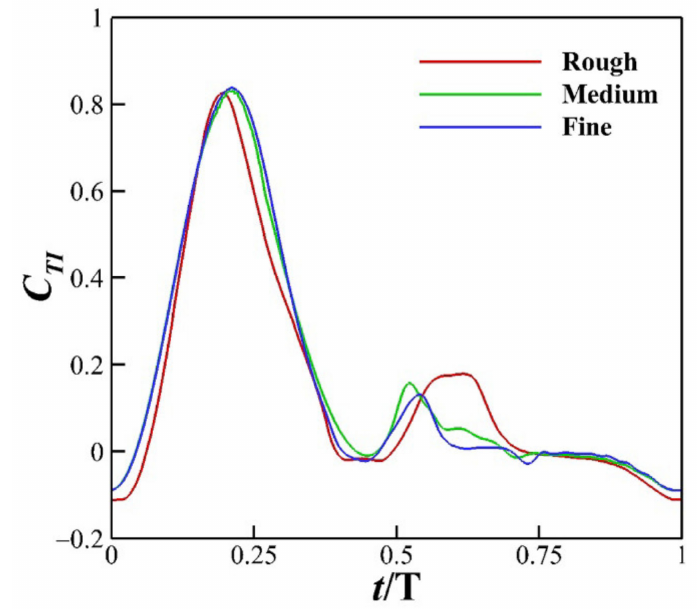
Figure 5. Comparison of instantaneous torque coefficients of a single blade in one cycle for three meshes.